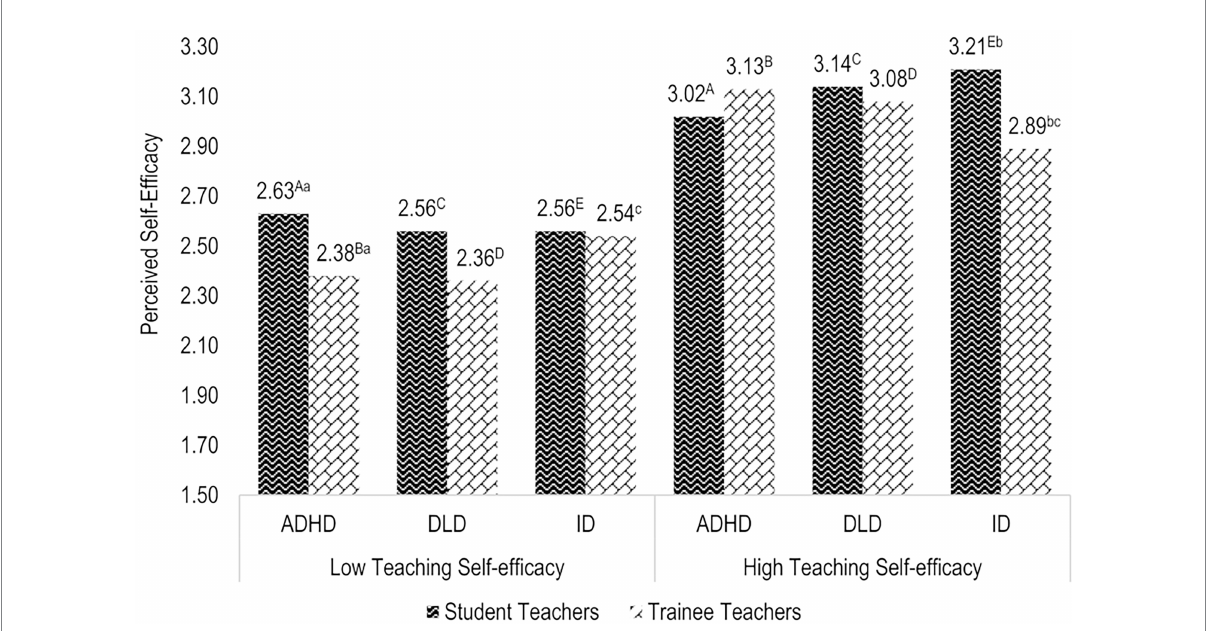
FIGURE 4 Estimated marginal means of the effect of the three-way interaction between type of disability × respondents’ teaching efficacy × respondents’ student/trainee teacher status on perceived self-efficacy in the context of inclusive education. Means sharing the same capital letter differ significantly at p < 0.01. Means sharing the same lower case letter differ significantly at p < 0.05 (Sidak-corrected post hoc